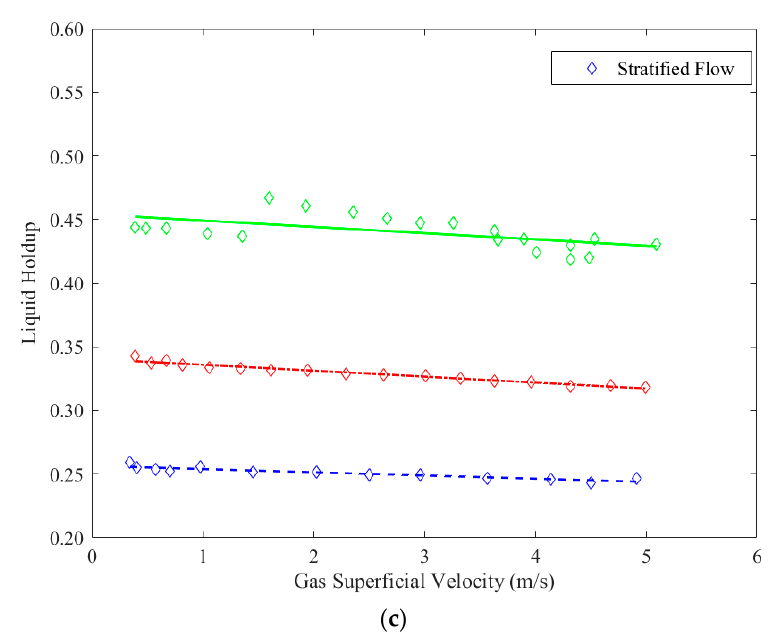
Figure 9. The relationship between ε (L) and flow pattern, based on superficial phase velocity coordinates ( u ( L ) : Blue: 0.135 m / s, Red: 0.276 m / s and Green: 0.506 m / s), ( a ) at pipe inclination angle of 0 ◦ , ( b ) at upward pipe inclination angle of 9 ◦ , and ( c ) at downward pipe inclination angle of 9 ◦ .